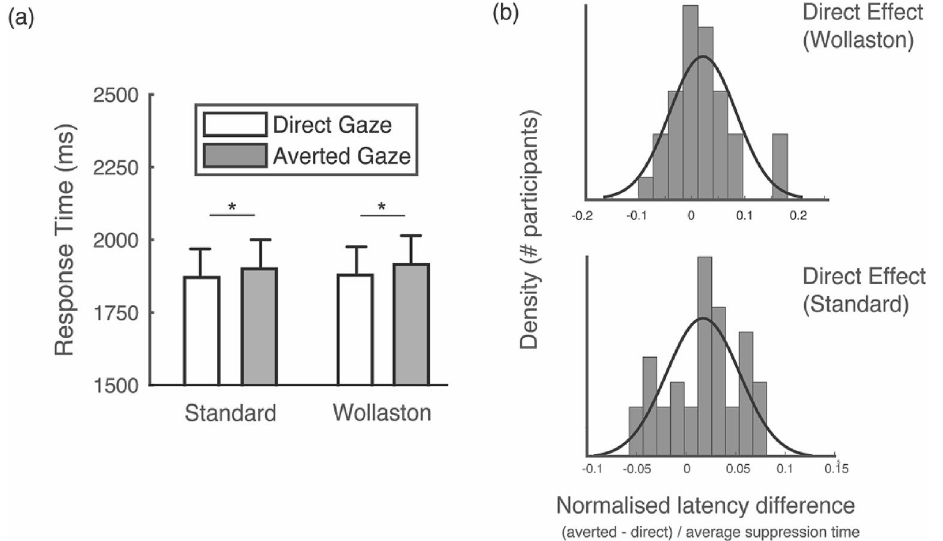
Figure 5. Mean suppression times for each condition ( a ). Error bars denote ± standard error. *(p < 0.05). ( b ) Sample distributions of the direct effect (i.e., the extent to which faces with direct gaze are detected faster than faces with averted gaze) are reported as latency normalised mean differences in suppression times between averted and direct conditions for Wollaston stimuli and Standard stimuli. Values above zero indicate a direct gaze effect. Note, not all participants show the direct effect with Wollaston or Standard